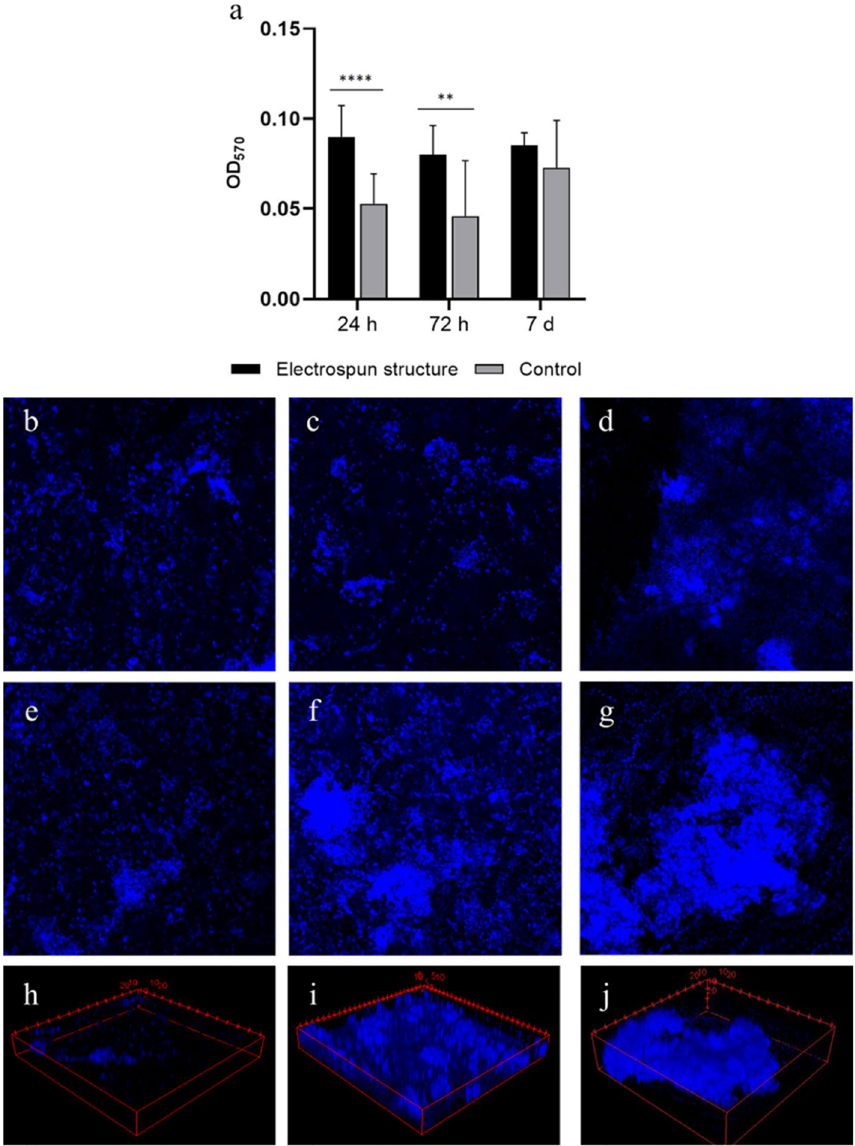
Figure 4. Analysis of the in vitro-cultured microbial biomasses. (a) Crystal violet quantification of microbial consortia at 24 h, 72 h, and 7 days of incubation on the scaffolds (black bars) and on glass slides (control, grey bars). ** p < 0.01, **** p < 0.0001; (b–d) visualization of the DAPI-stained biomasses at 24 h (b) , 72 h (c) , and 7 days (d) of incubation on glass slides (× 10 magnification); (e–g) Z-stack visualization of the DAPI-stained biomasses at 24 h (e) , 72 h (f) , and 7 days (g) of incubation on the electrospun scaffolds (×10 magnification); (h– j) 3D visualization of the DAPI-stained biomasses on the electrospun structures at 24 h (h) , 72 h (i) , and 7 days (j) post inoculation. The three-dimensional development of a biofilm that expands over the entire thickness of the structure is